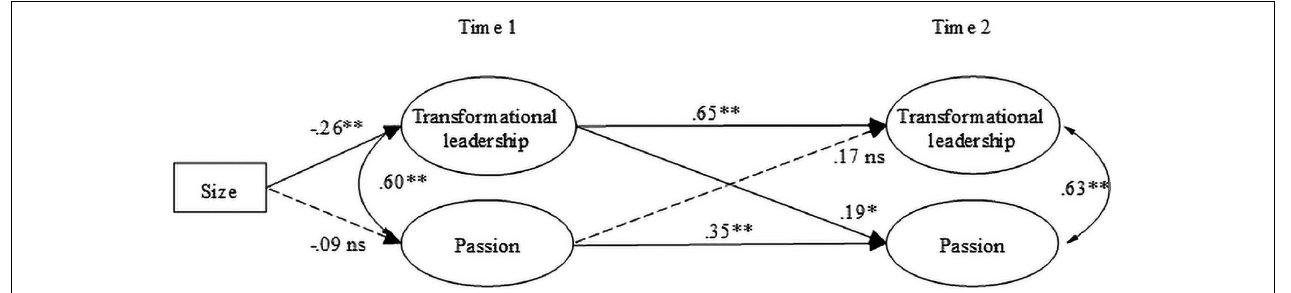
FIGURE 2 | First part of the mediation model. ∗∗ p < 0.01; ∗ p < 0.05; ns, non-significant.